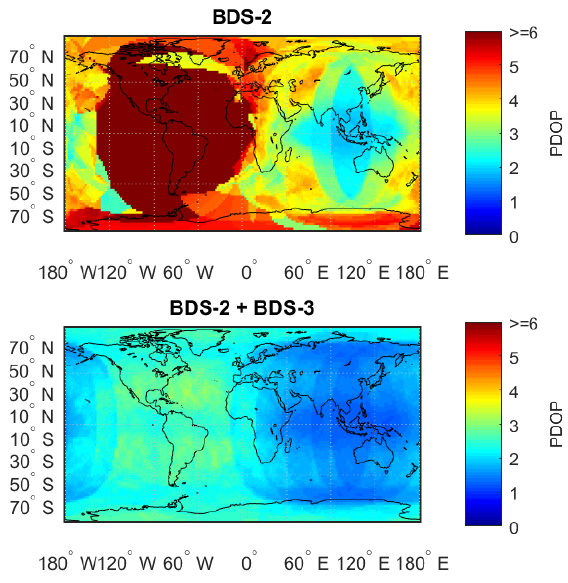
Figure 2. Average PDOP value of BDS-2 ( upper ) and BDS-2 + BDS-3 ( lower ) for an elevation angle mask of 10 ◦ on 1 January 2019. Only value of PDOP < 6 is counted.